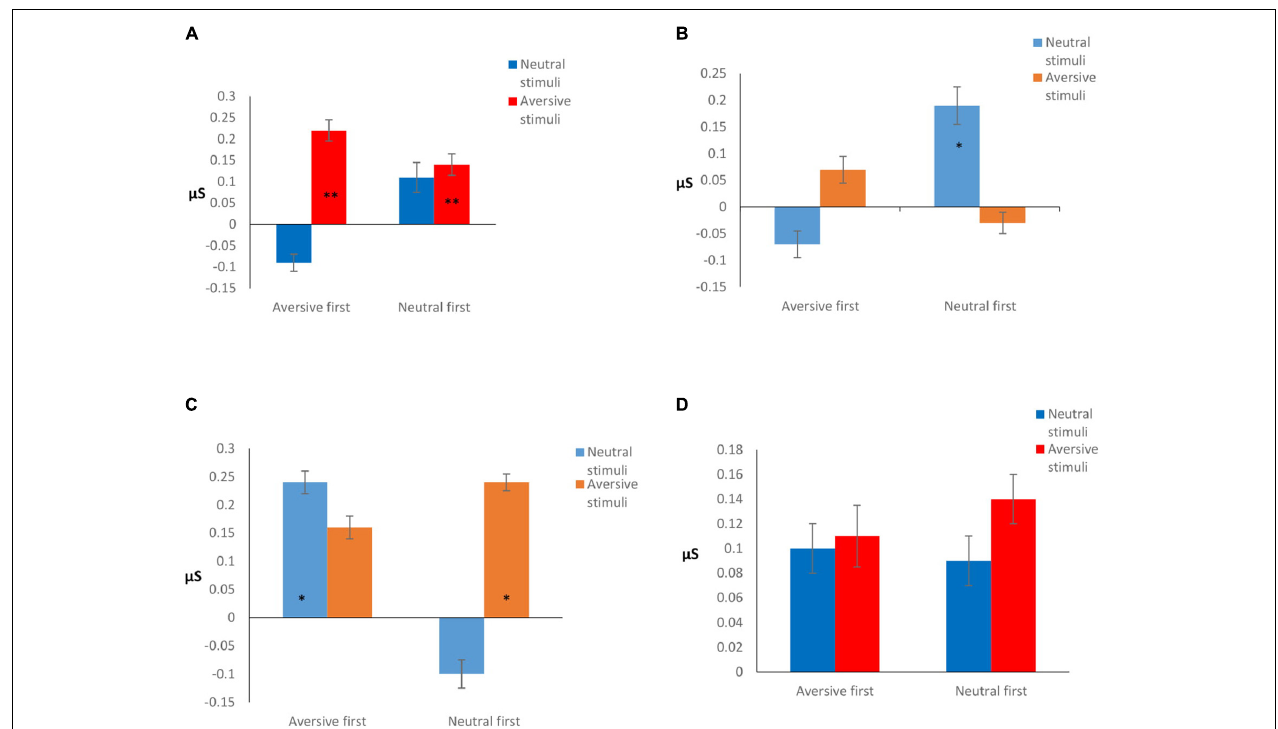
FIGURE 3 | (A) High OCS sensitivity. **Significantly higher reaction compared to low OCS aversive stimuli ( p = 0.038), and compared to high OCS reaction to the neutral stimuli ( p < 0.001). (B) Low OCS sensitivity. *Significantly higher reaction to the neutral stimulus when it was presented first ( p = 0.014), compared to the low OCS reaction to the aversive stimuli in the same condition. (C) Low OCS habituation. (D) High OCS habituation. Habituation is calculated as the difference between the stimulus average and the rest average after stimulus presentation. The higher the difference, the better the habituation. *Significantly different in habituation between conditions ( p = 0.035), and stimulus type ( p =